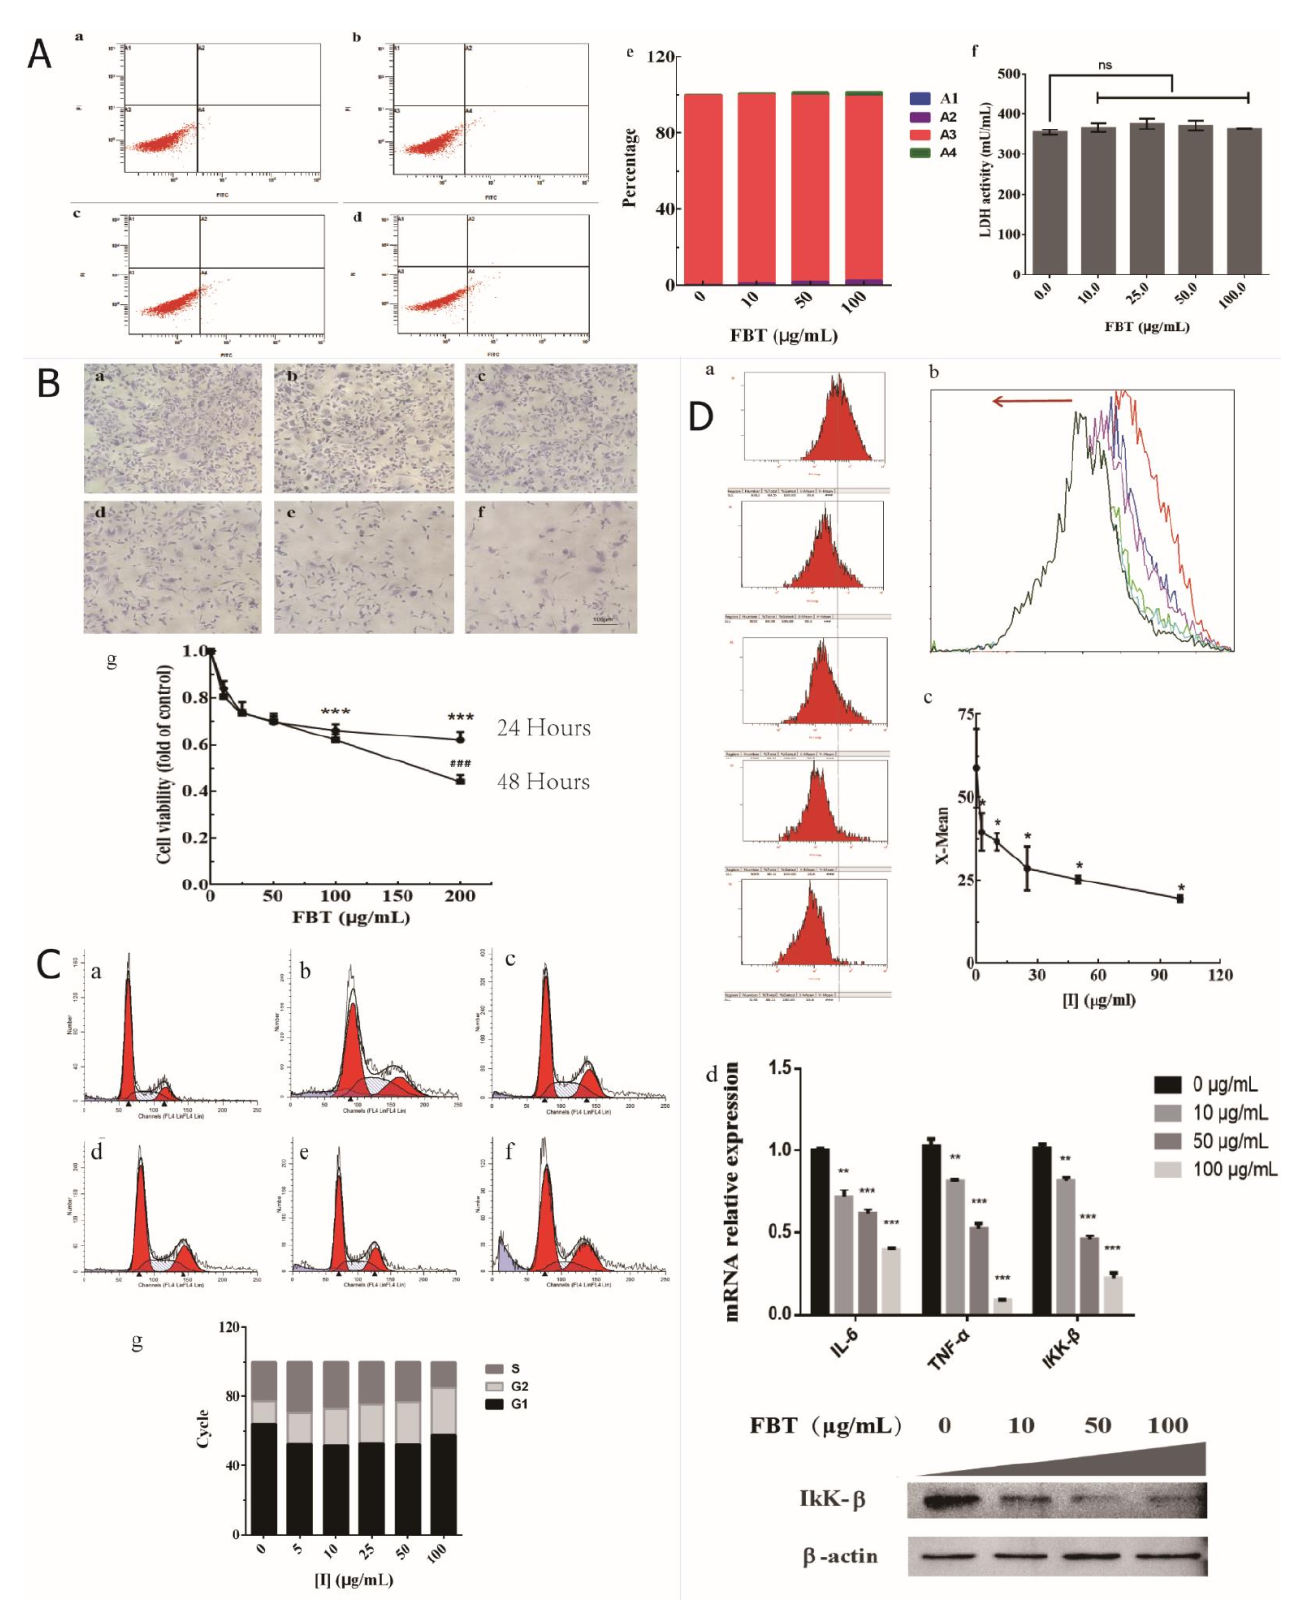
Figure 3. Effects of FBT on 3 T3-L1 preadipocytes. A: Effect of FBT on the apoptosis rate of 3T3-L1 preadipocytes. ( A-a ) Blank control; ( A -( b–d )) FBT dosage was 10, 50, and 100 µ g/mL,